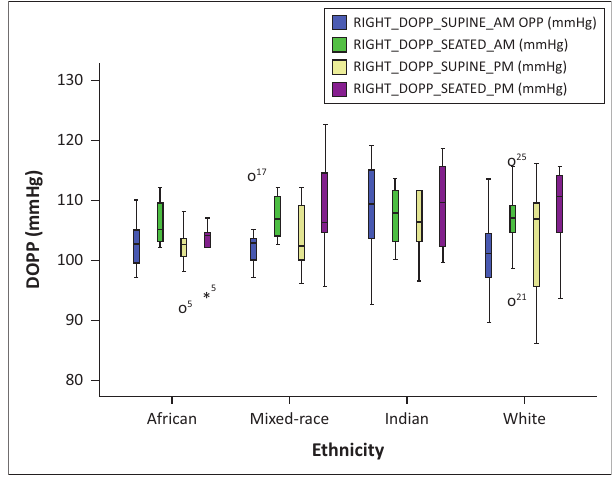
FIGURE 3: Box plot for diastolic ocular perfusion pressure and different ethnicities in the seated and supine position in the morning and TABLE 3: Wilcoxon signed-rank test, comparing different races at a 95 % confidence interval. Ethnicity Observation comparison